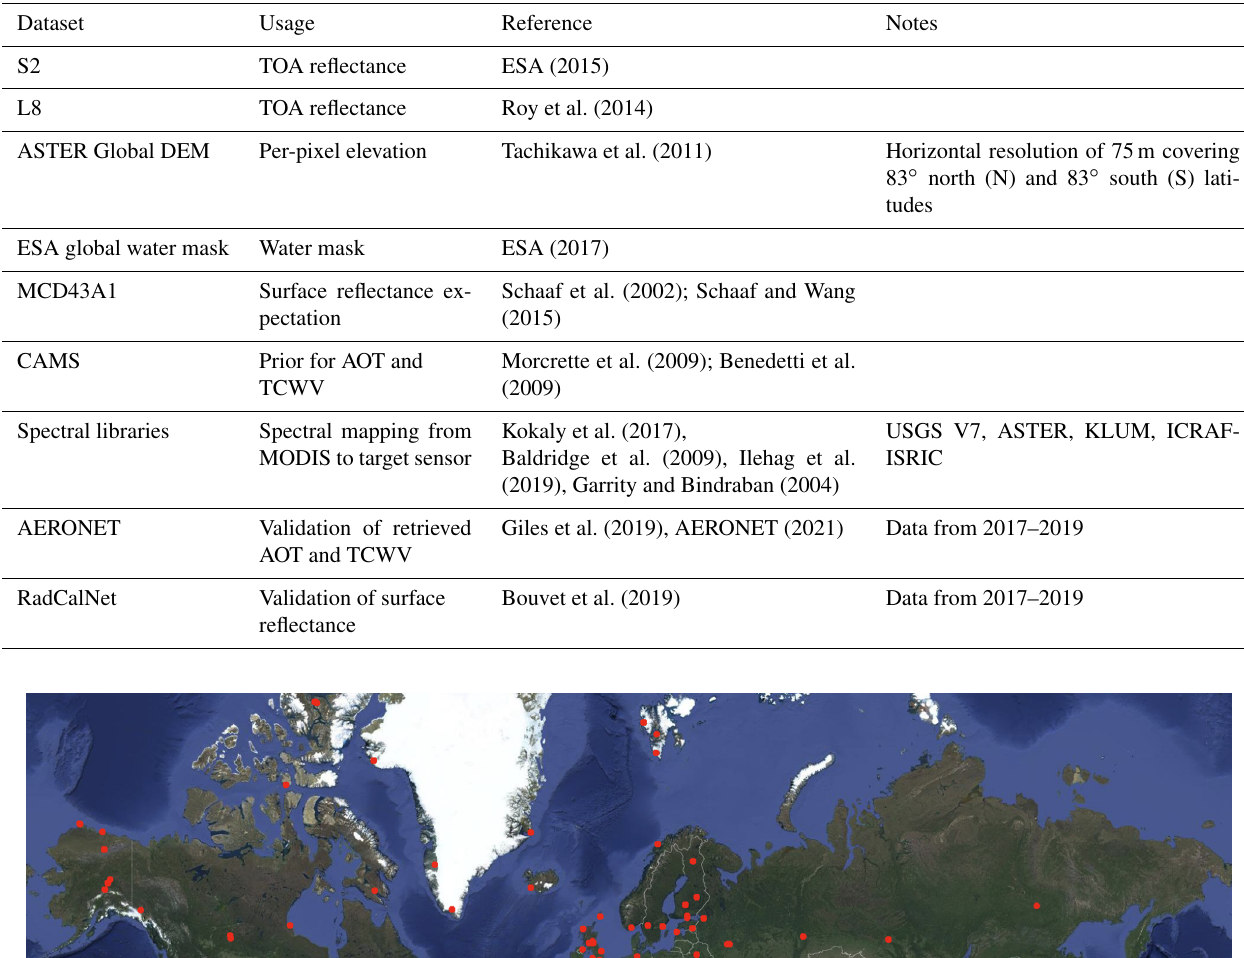
Table 4. Datasets used in SIAC.